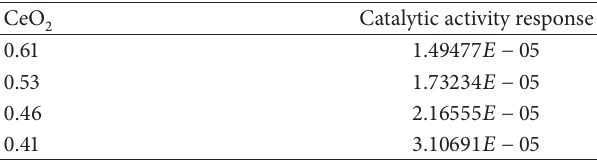
Table 4: Effect of CeO 2